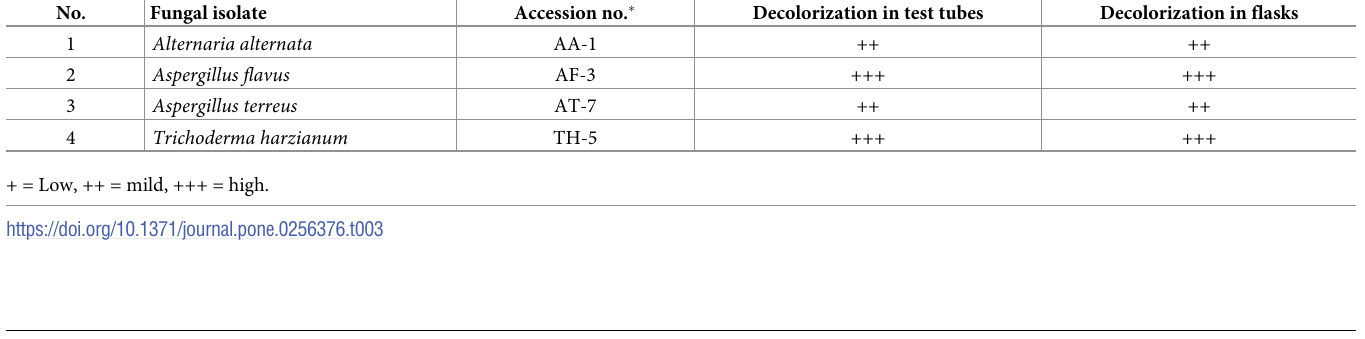
Table 3. Biodegradability experiment (DCPIP) by test tubes and flasks. No. Fungal